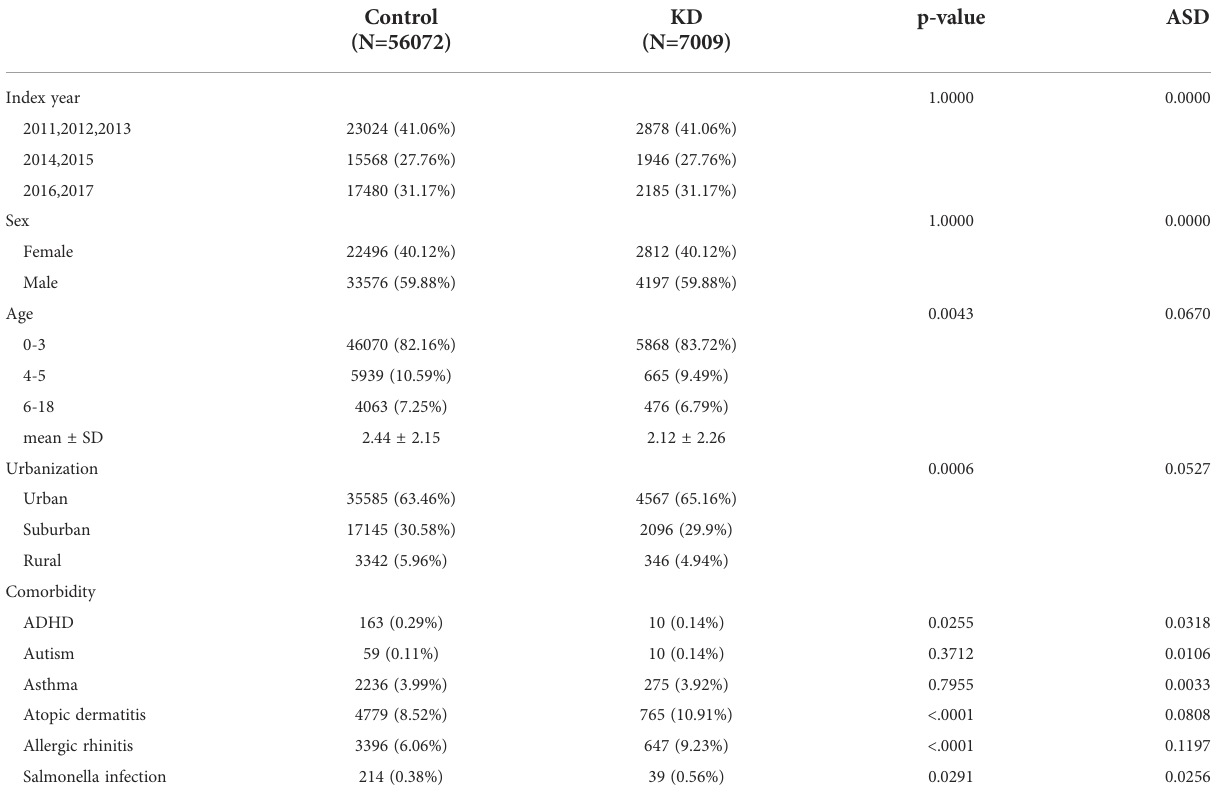
TABLE 1 Demographic characteristics of the patients with KD and matched